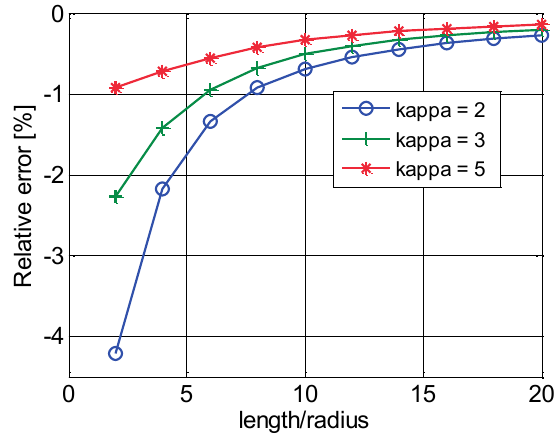
Figure 11: Relative error of the mutual inductance formula (53) from the literature plotted in function of the ratio for three values of the parameter